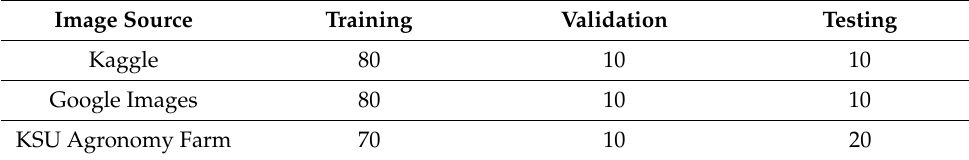
Table 1. Training, validation, and testing splits (%) for different data sources. Image Source Training Validation Testing